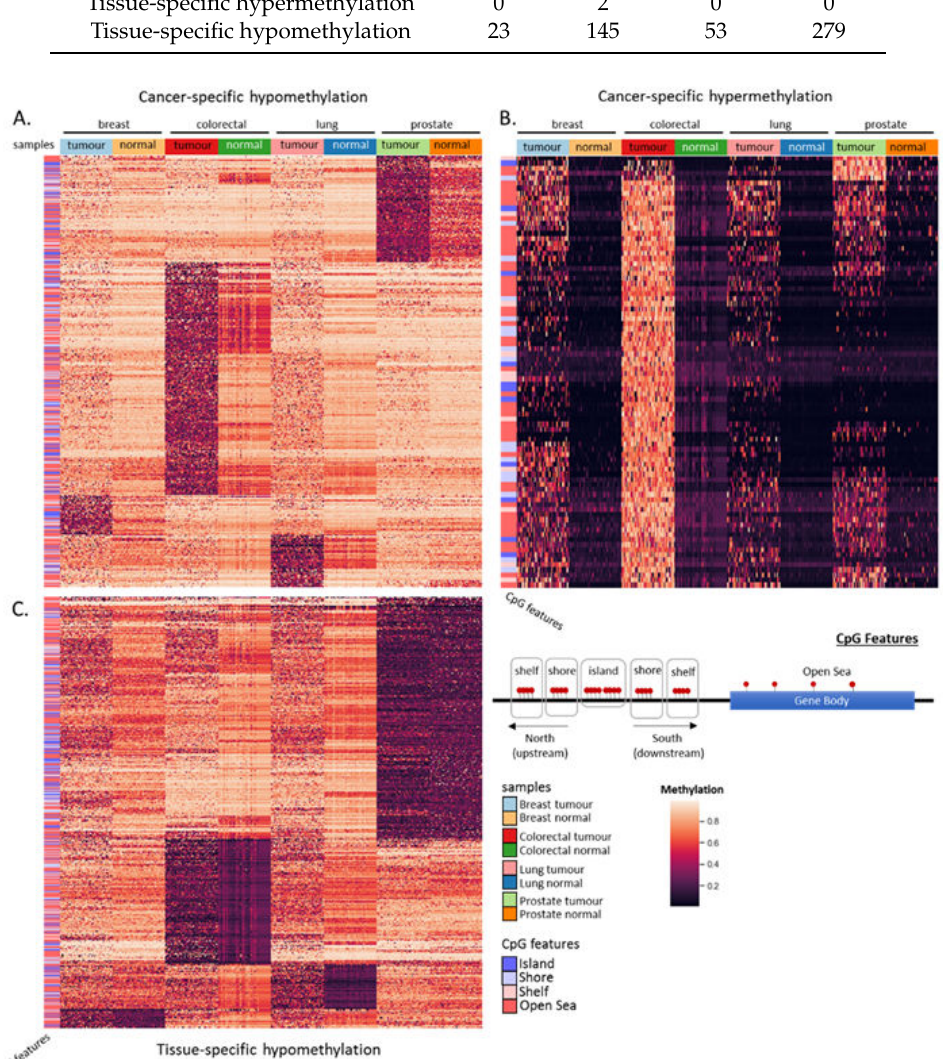
Figure 6. Visualization of MethylMine-filtered biomarkers of four cancers from the TCGA. Validation of MethylMine-filtered CpG sites across four cancers using semi-unsupervised clustering was performed with the following parameters applied on the CpG sites (row): method = average, metric = Euclidean. Filtered samples were further separated into ( A ) cancer-specific hypomethylation (samples from tumors of specific cancers are hypomethylated), ( B ) cancer-specific hypermethylation (samples from tumors of specific cancers are hypermethylated), ( C ) Tissue-specific hypomethylation (samples from tissues of specific sites are hypomethylated). CpG sites corresponding to di ff erent features are in the rows, while samples from either tumor or normal tissue of the four analyzed cancers are in the